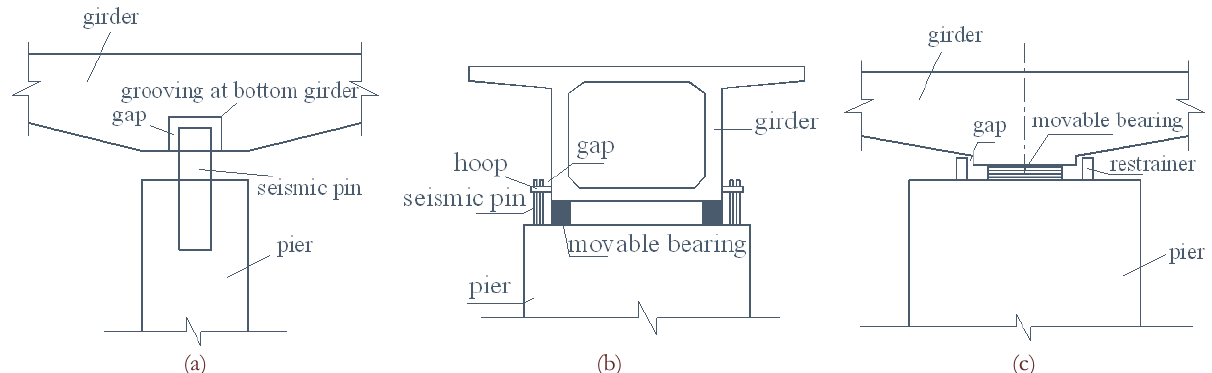
Figure 1: Seismic tectonic measure at movable piers. (a) Longitudinal seismic pin; (b) Lateral seismic pin; (c)